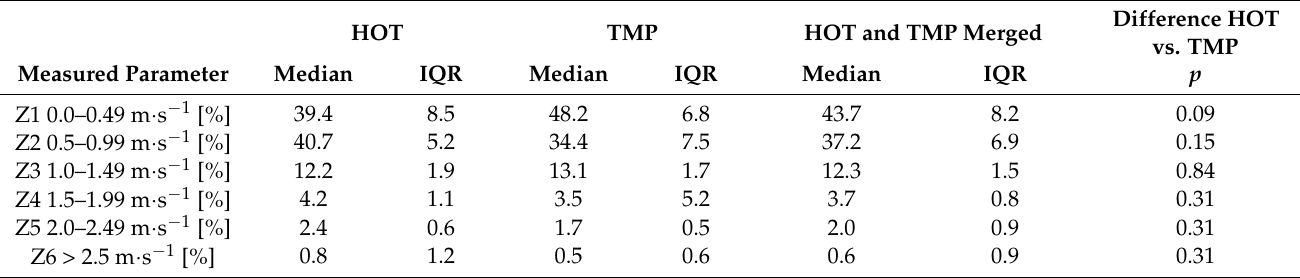
Table 3. Percentage of time spent in different speed zones of two wheelchair basketball games, one in hot and one in temperate environmental